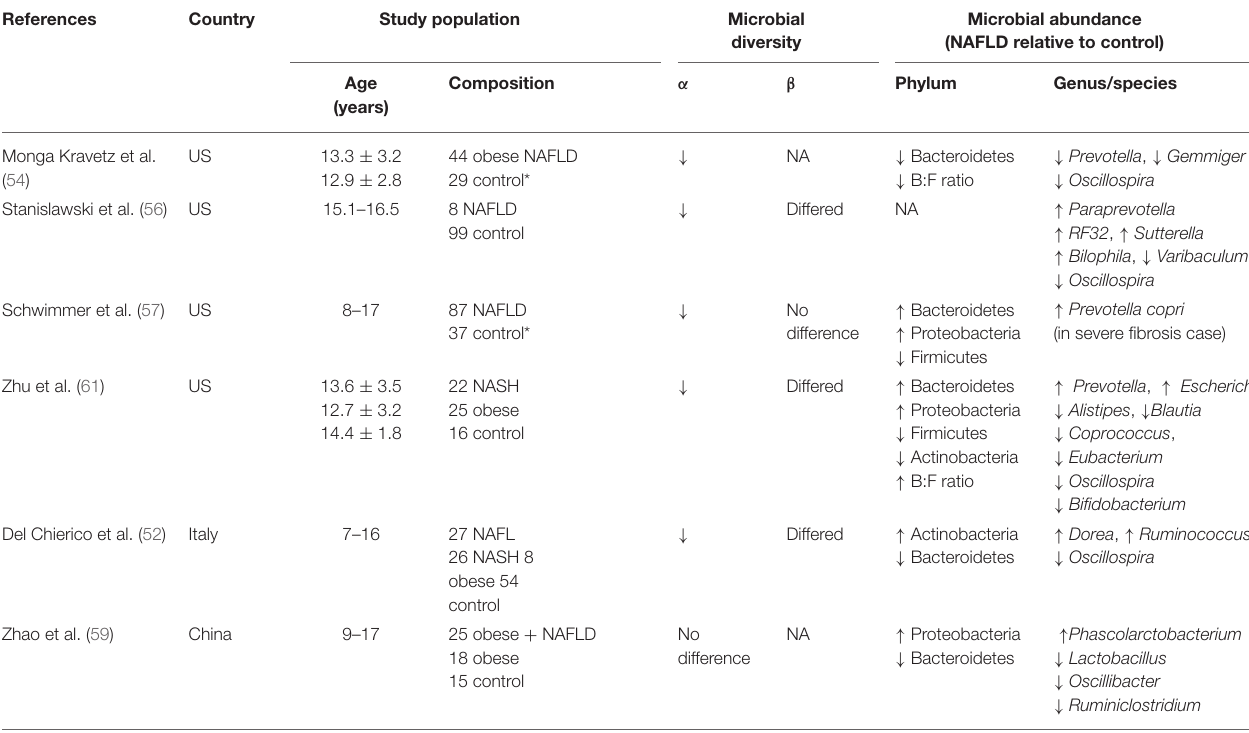
TABLE 1 | Alteration of gut microbiota composition in children and adolescents with non-alcoholic fatty liver disease (NAFLD).